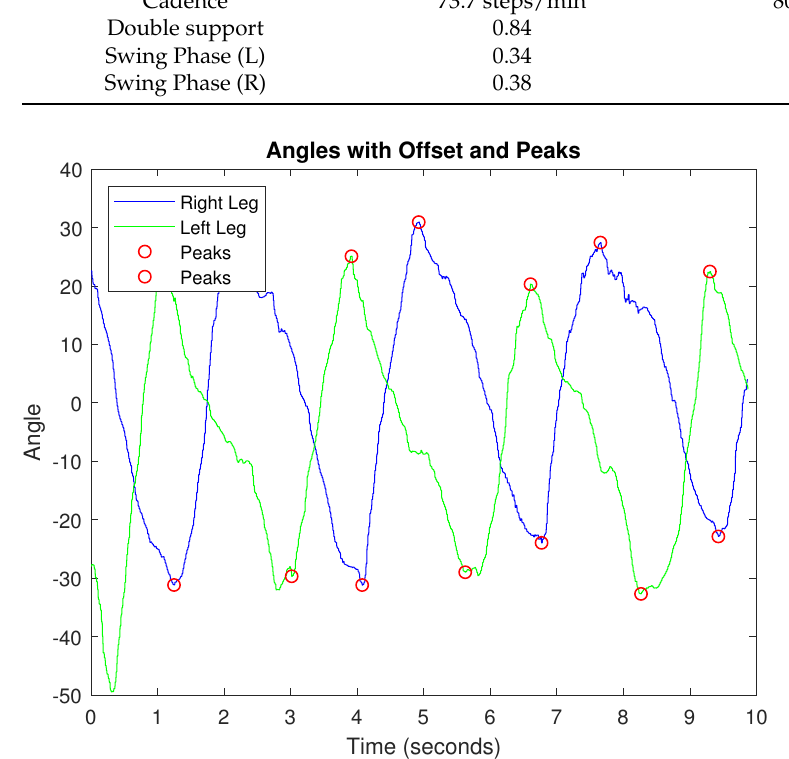
Figure 5. The recorded knee angle data for gait